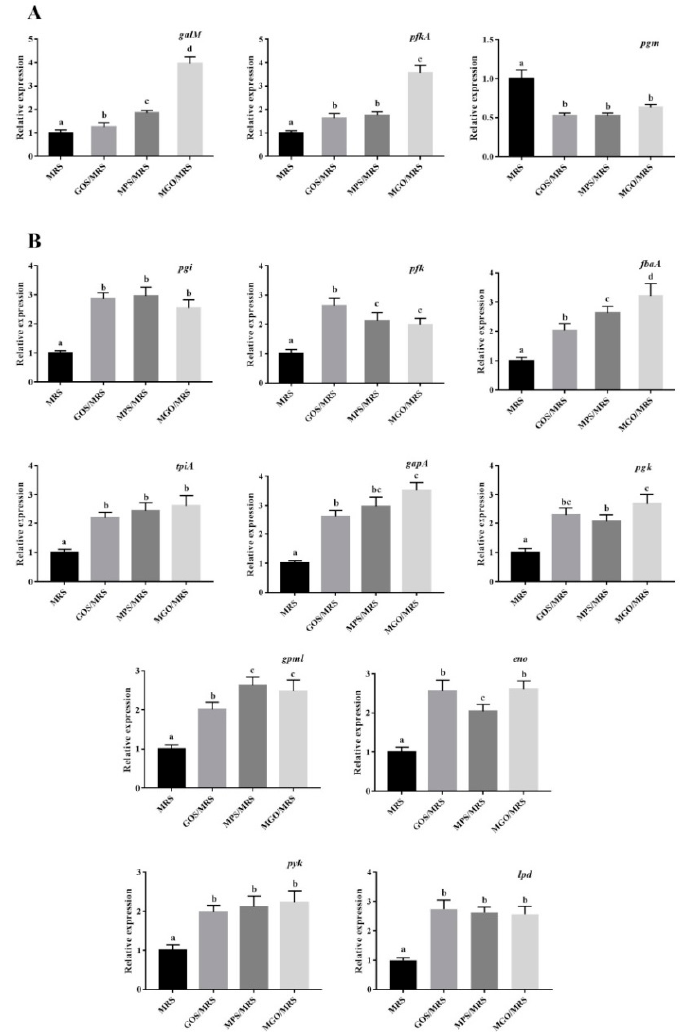
Figure 6. The qRT-PCR results to validate the transcriptions of galactose-metabolism-pathway-related genes ( A ) and glycolysis/gluconeogenesis-pathway-related genes ( B ) mentioned in RNA- seq data.